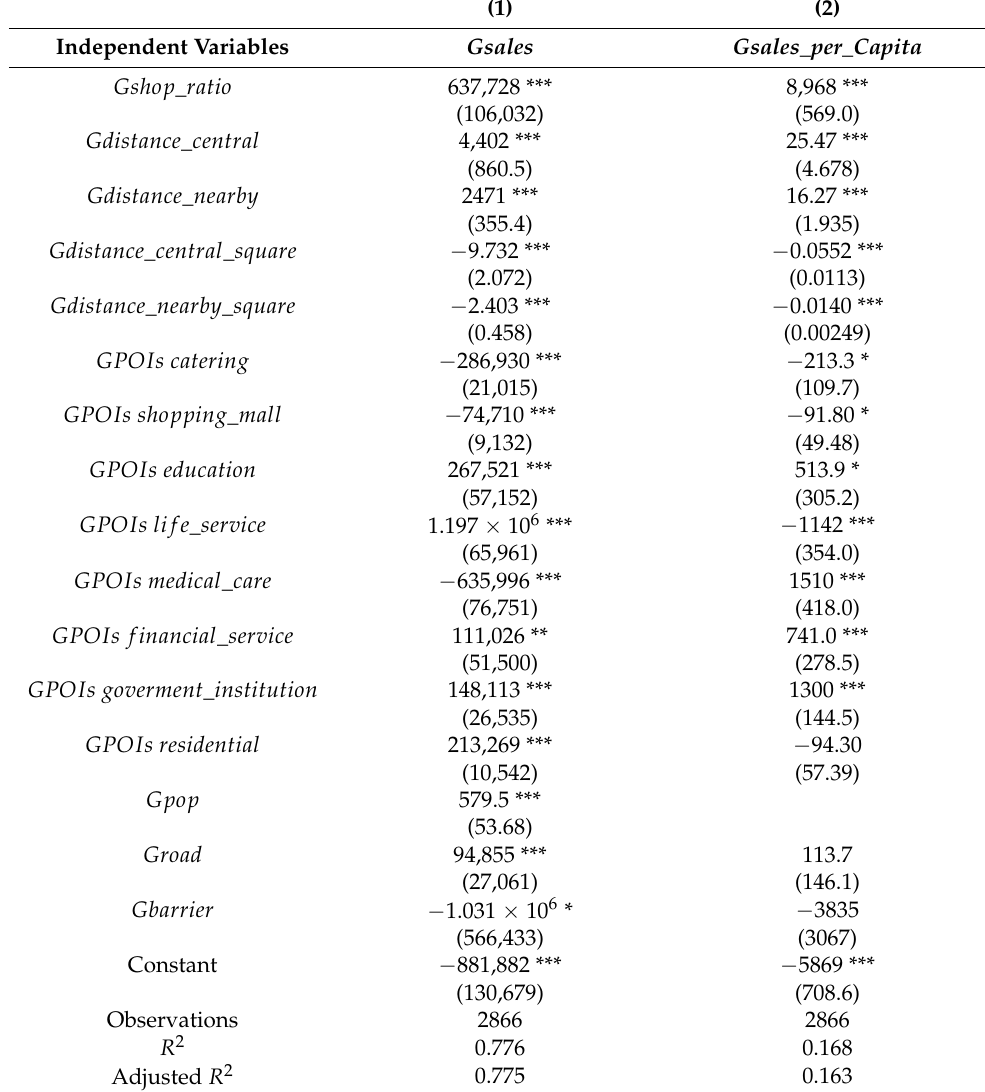
Table 6. Robustness check using per capita